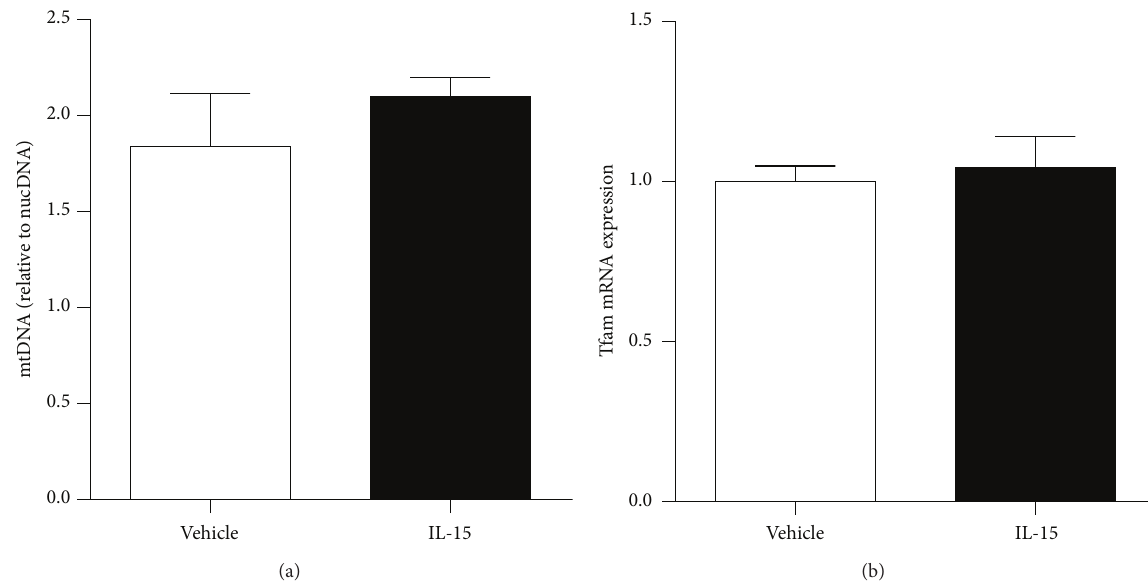
Figure 3: Effects of IL-15 signaling on mitochondrial biogenesis. (a) mitochondrial DNA (mtDNA) assessments; (b) mRNA expression of mitochondrial factor Tfam. Assessments were carried out on differentiated C2C12 myotubes following treatment with 100 ng/mL of IL-15 every other day for 6 days during the differentiation protocol. mtDNA was normalized to the total nuclearDNA (nucDNA) content. GAPDH was used as an internal control for qPCR analysis. All values are displayed as means ± SEM, 𝑛 = 6 .